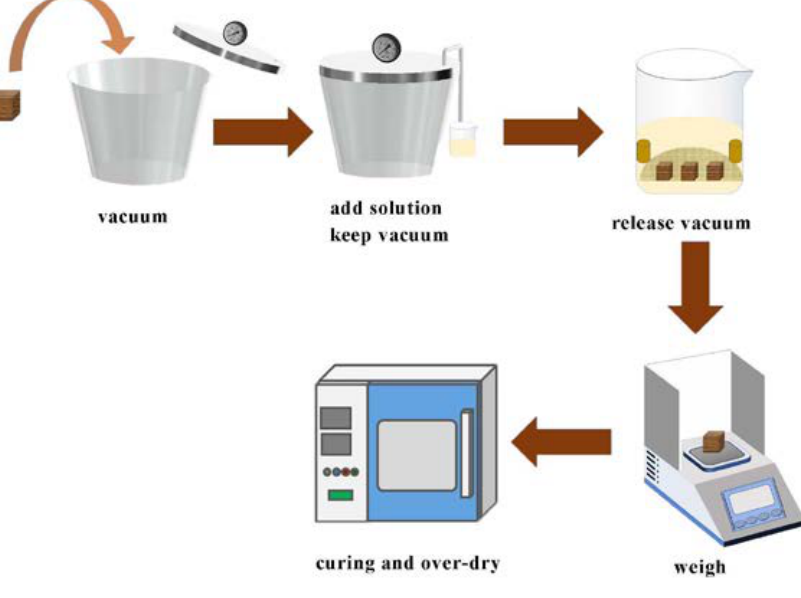
Figure 1. Diagram of the furfurylation process.